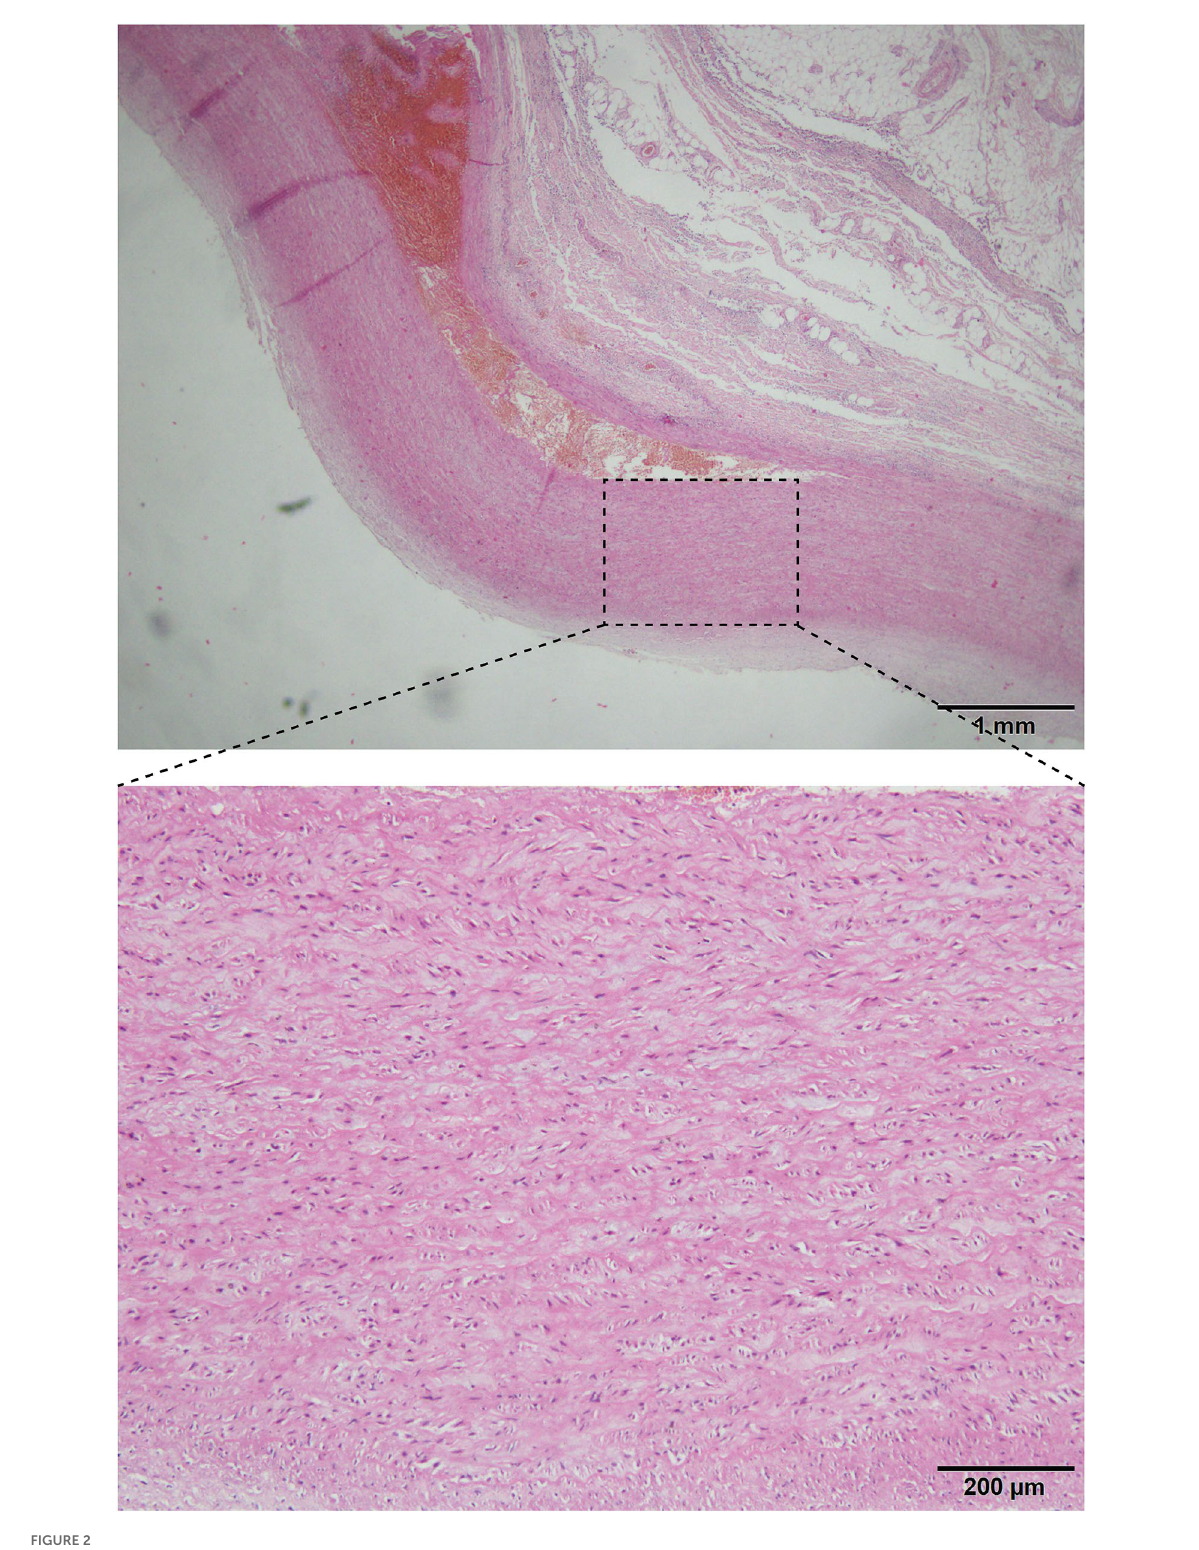
FIGURE2 Aorta of a TAD